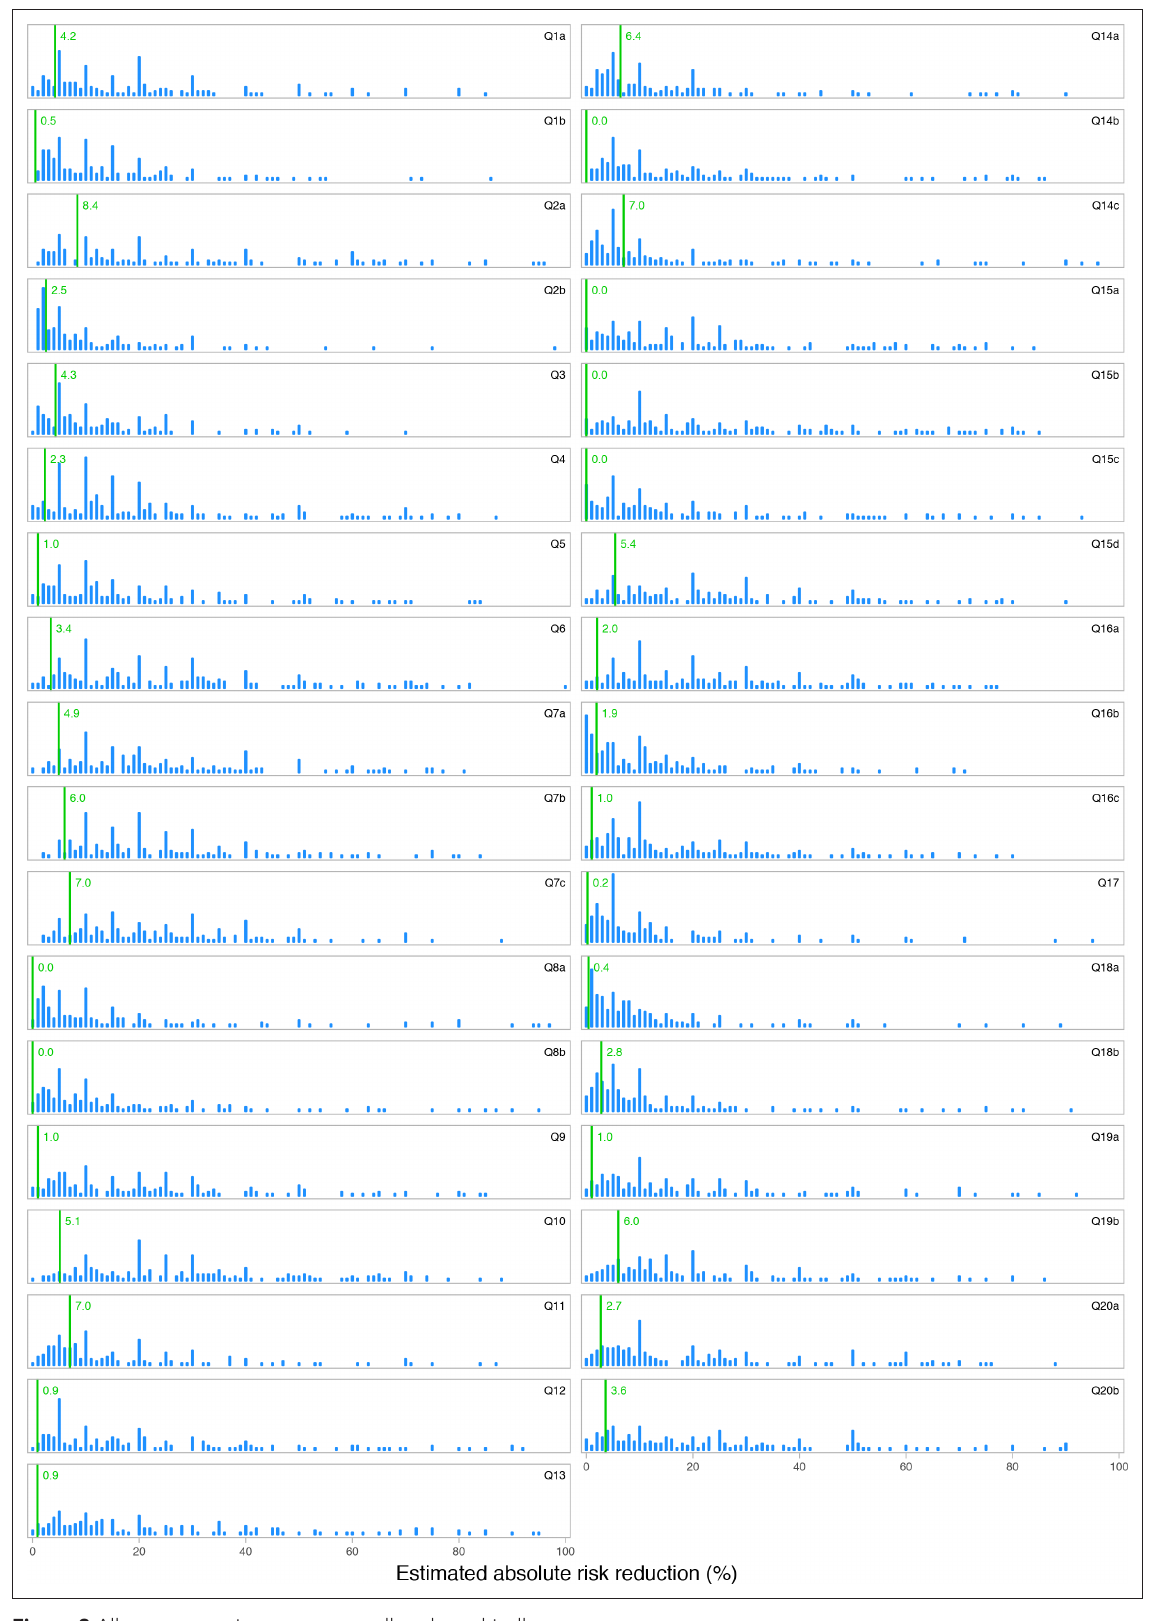
Figure 3 All survey question responses collated graphically. Green line = correct